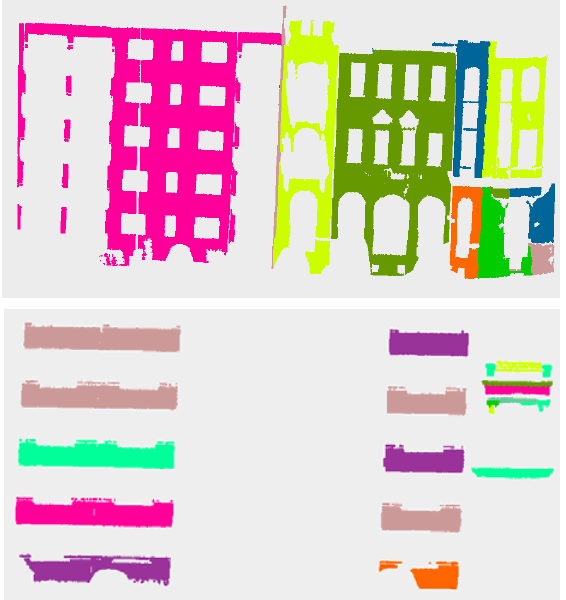
Figure 8. Feature recognition results – Case 2. Upper: Detected walls; Lower: Detected